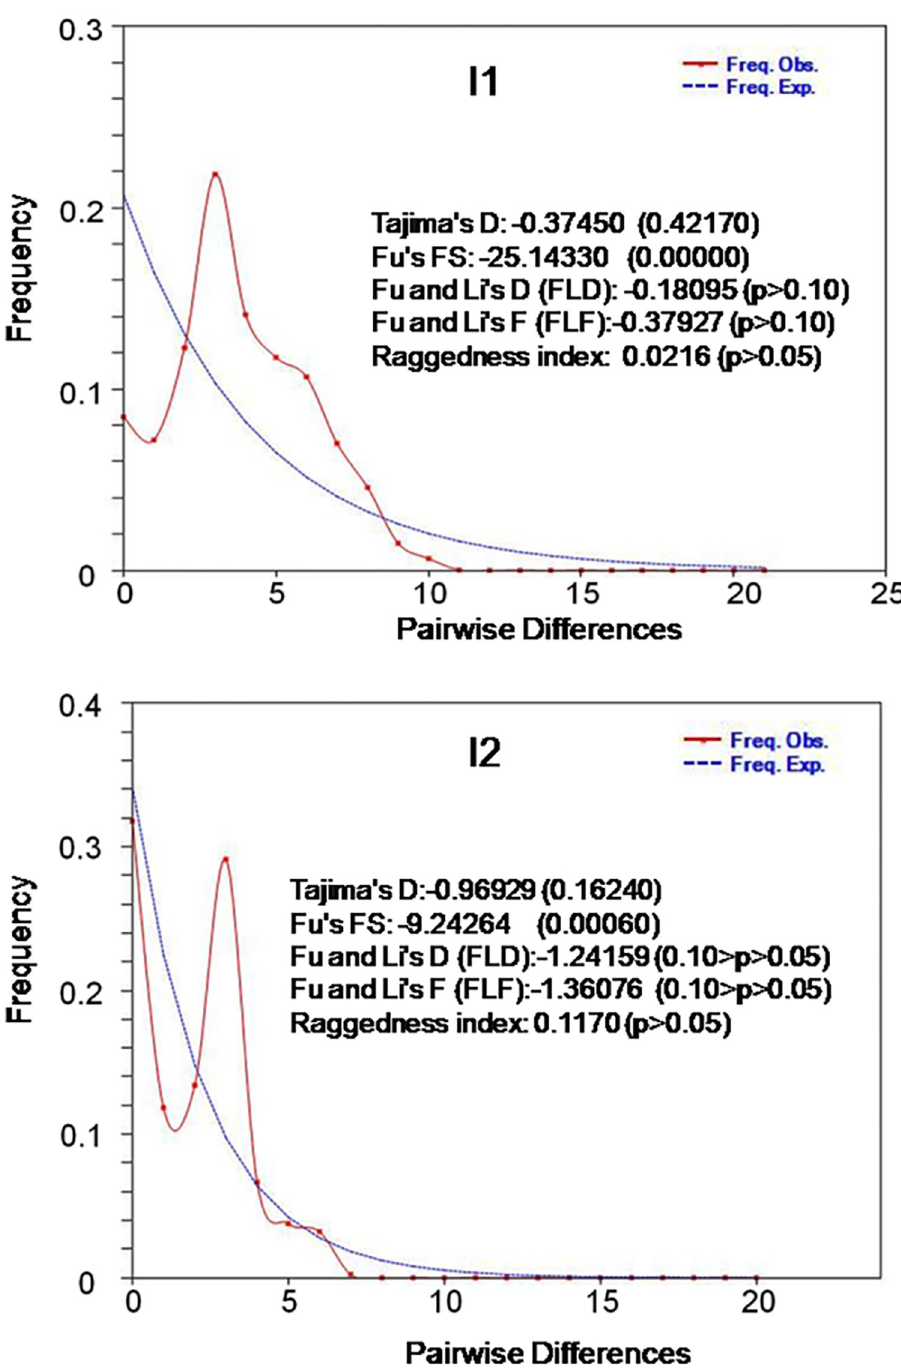
Fig 8. Mismatch distribution graph and neutrality tests of Andaman cattle. The x and y axis present number of pairwise differences and the relative frequencies of pairwise comparisons respectively. Mismatch distribution graph was drawn in DnaSP v 6 [38] and neutrality tests were calculated in DnaSp v 6 [38] and Arlequin v 3.5 [45].